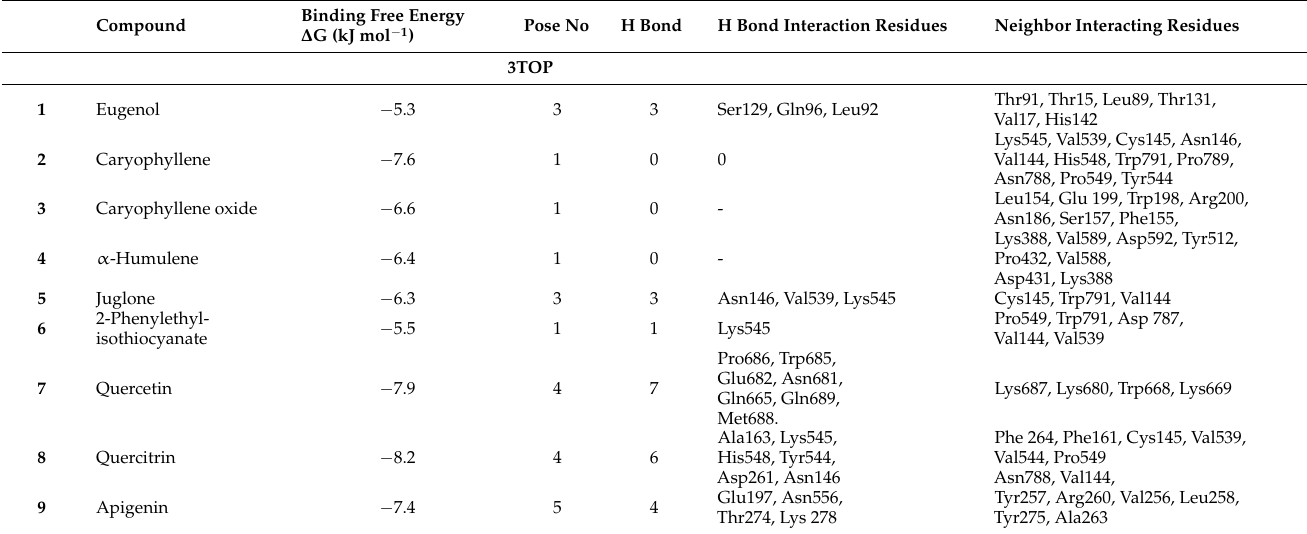
Table 1. Docking score, H and non-H bonding interactions of test compounds for transcriptional regulator 3TOP ( α